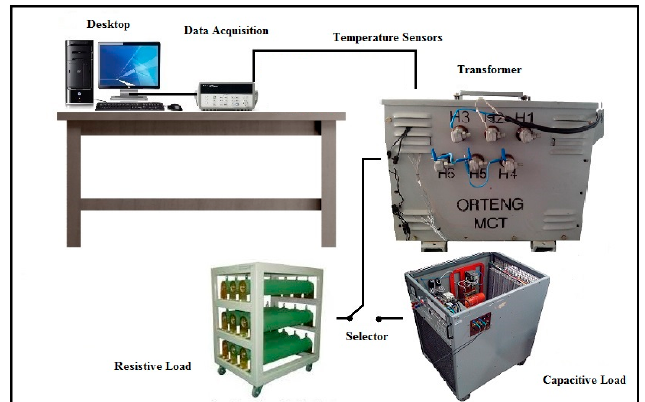
Figure 4. Experimental apparatus.